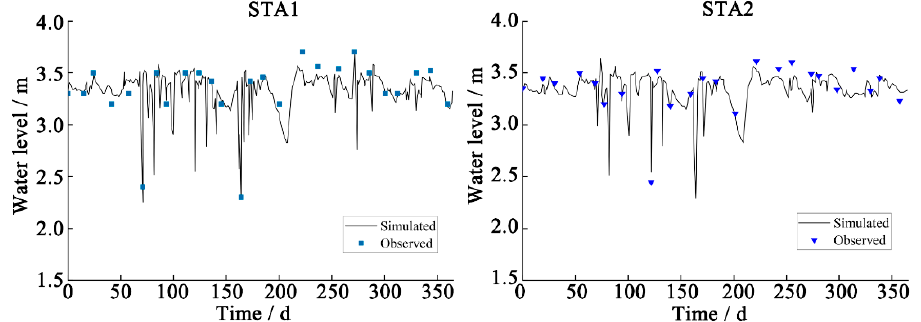
Figure 5. Water level calibration results of the MIKE11 model for the target area.